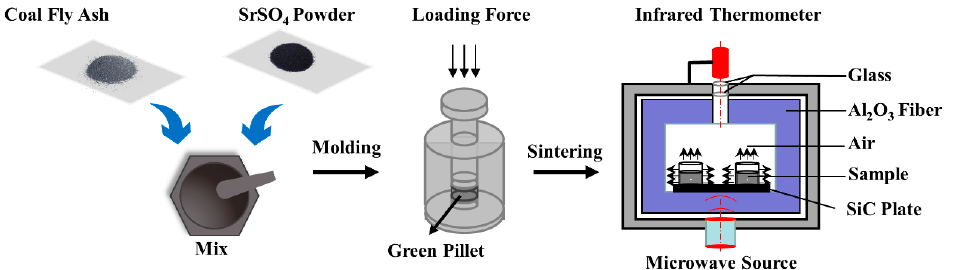
Figure 2. Schematic of the experimental process.